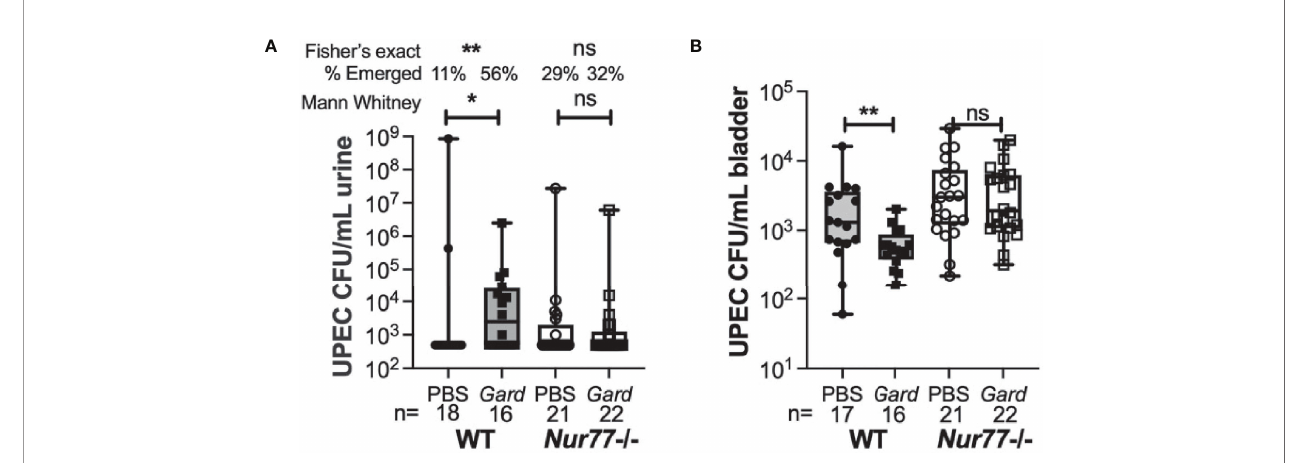
FIGURE 5 | Mice lacking Nur77 are protected from Gardnerella -induced UPEC reservoir emergence. Mice harboring bladder UPEC reservoirs were exposed to PBS or Gardnerella twice at a one-week interval. Urines were collected daily for three days after the second exposure and mice were euthanized after three days. (A) Shown are the highest UPEC urine titers of each individual mouse. (B) Bladder UPEC titers are shown. The number of mice in each group is given at the bottom of the graphs. *P < 0.05; **P <